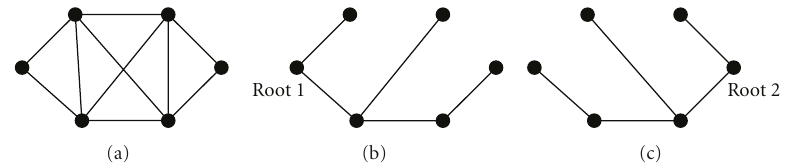
Figure 3: (a) Example of loopy graph, (b), (c) Spanning trees created by BFS method.